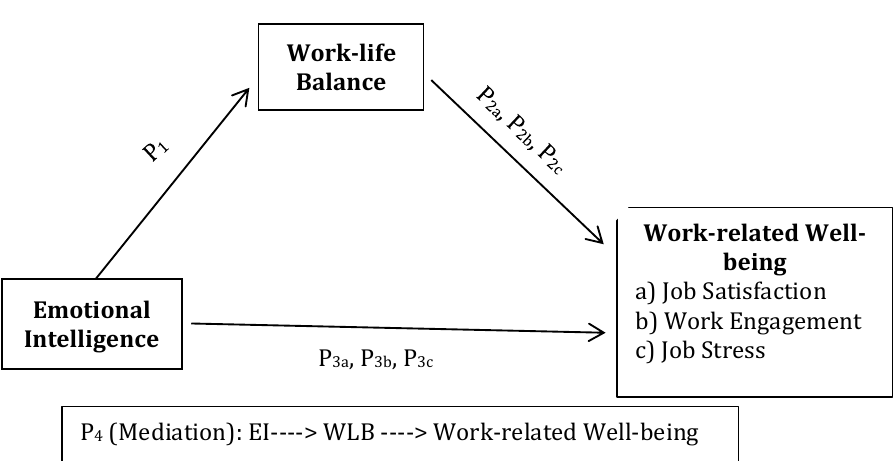
Figure 1: Relationships between EI, WLB, and Work -Related Well-being